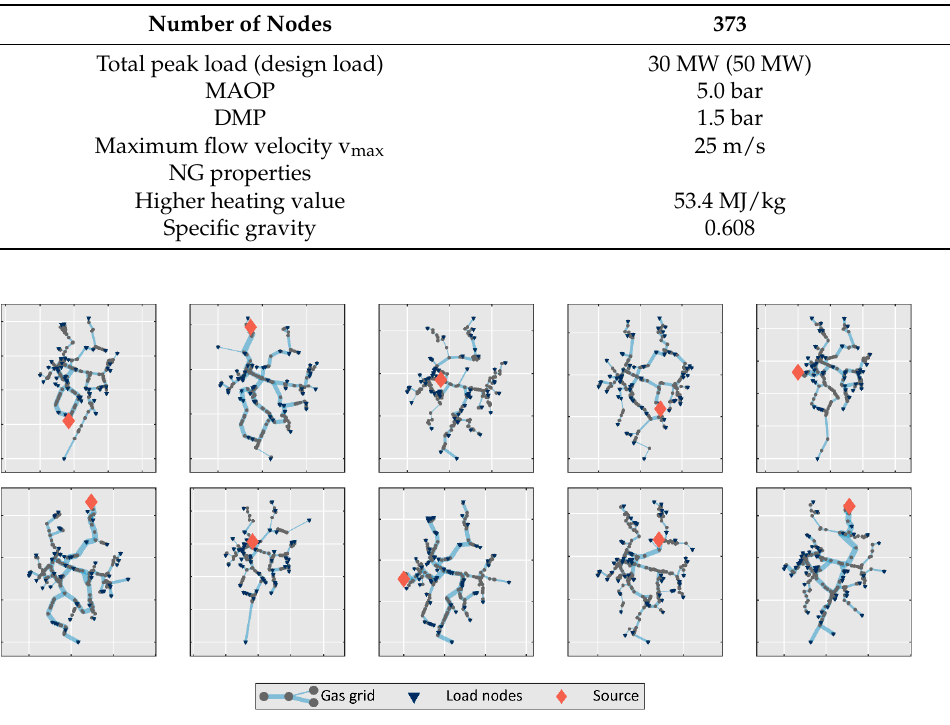
Figure 2. Sample of 10 synthetic networks among the 1000 models used for the study. Table 1. Inputs adopted for the creation of synthetic networks and their technical sizing.